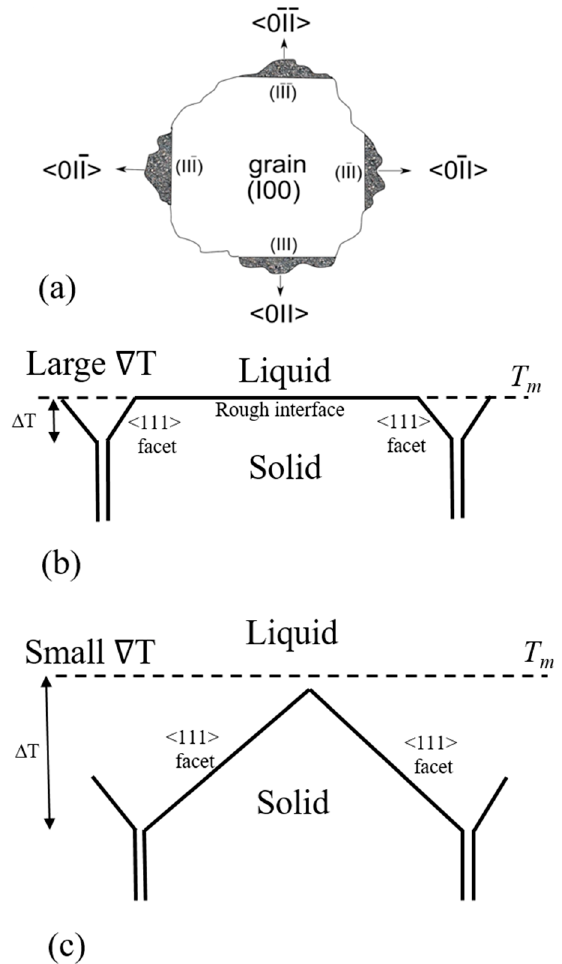
Figure 6. ( a ) A (100) grain at the solid–liquid (S / L) interface, seen from the liquid, showing four < 111 > facets on its boundary. ( b ) Cut view of this grain, showing small facets and a large rough interface, under a large temperature gradient. ( c ) Cut view of the same grain with the same facet undercooling, showing that it is totally faceted under a small temperature gradient. Adapted from [12].